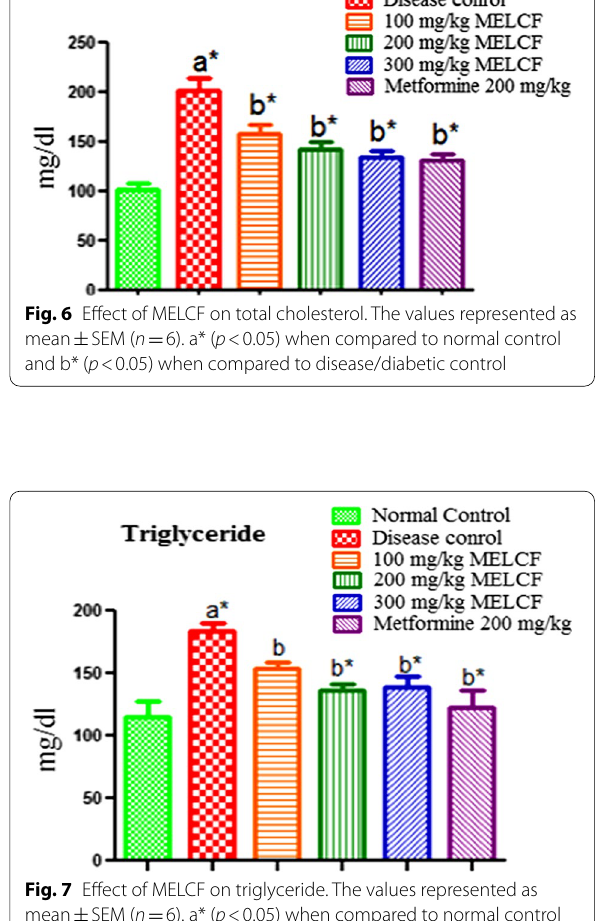
Fig. 7 Effect of MELCF on triglyceride. The values represented as mean SEM ( n 6). a* ( p < 0.05) when compared to normal control ± = and b* ( p < 0.05) when compared to disaese/diabetic control